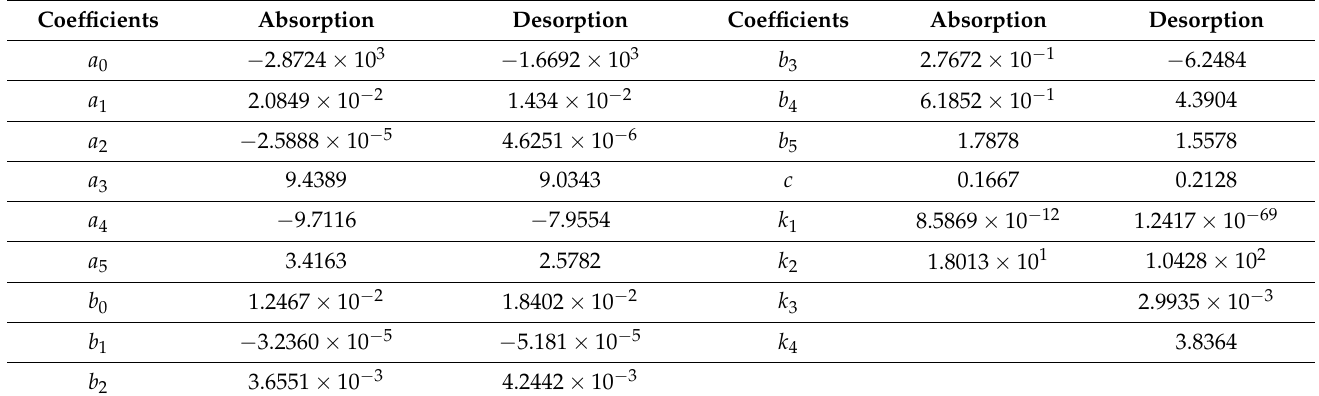
Table 2. Coefficients for absorption and desorption equilibrium pressure functions.